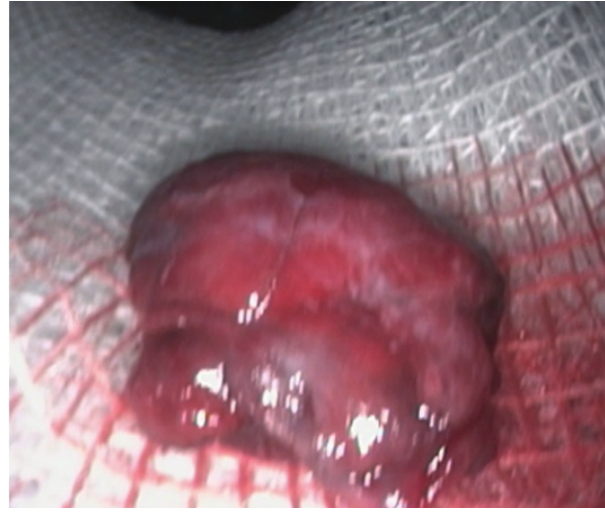
Figure 2. CT scan of the sinuses in axial section, with injection of contrast product: heterogeneous tissue mass filling the entire sphenoid sinus associated with lysis of the inter-sinus septum. Figure 4. Surgery